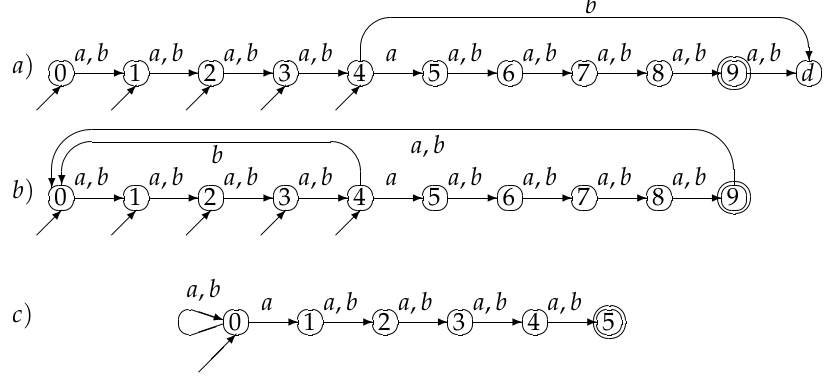
Figure 3. Example of 5-DFA having 11 states for L 4,4 ( a ), the corresponding 5-DFCA ( b ), and the corresponding NFCA ( c ). A corresponding equivalent minimal DFA for L 4,4 has 2 5 − 1 states and a minimal DFCA has 16